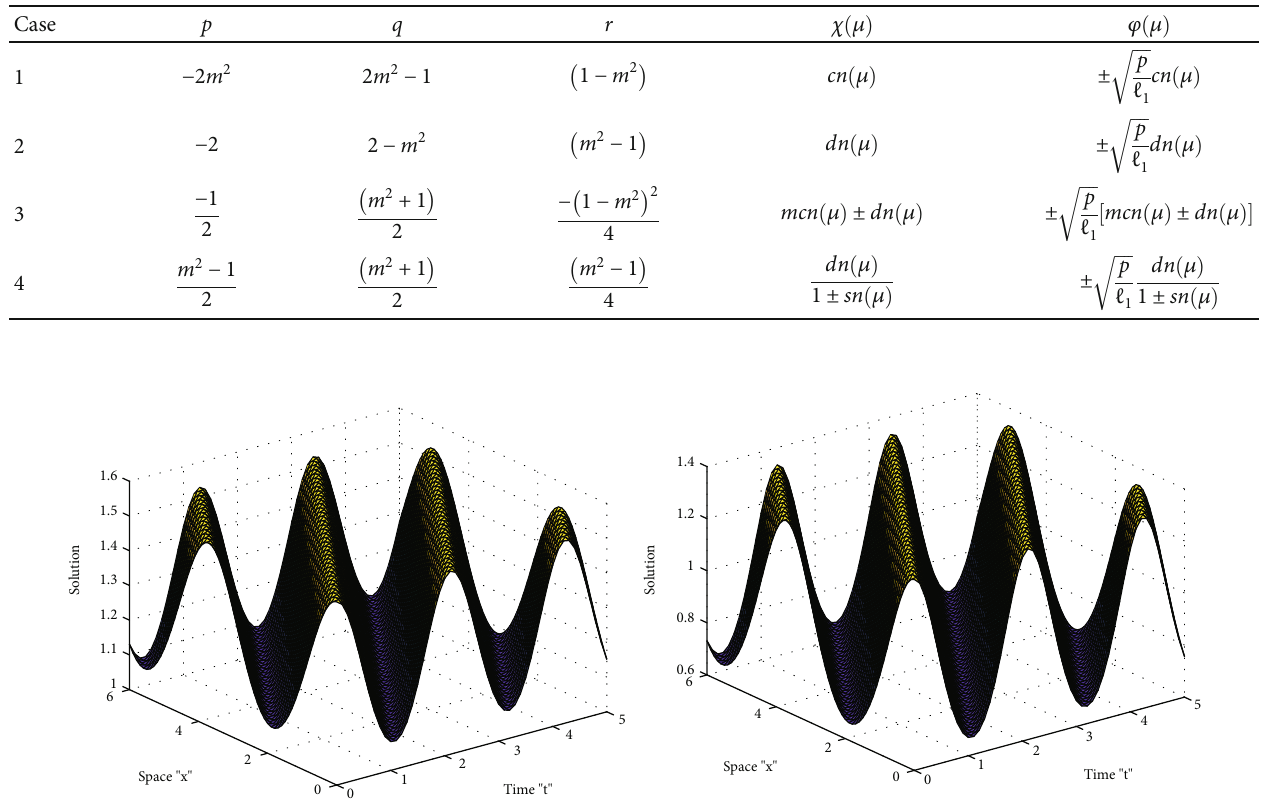
Table 5: All possible solutions for wave Equation (14) when p < 0 .